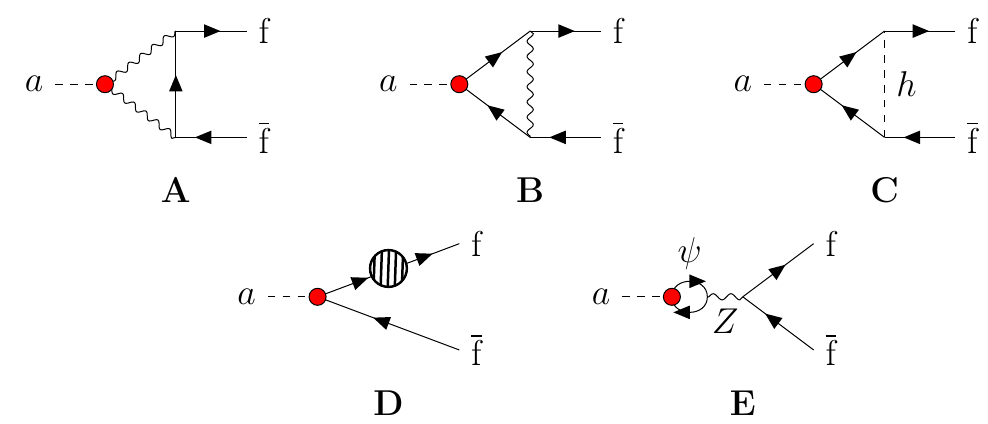
Figure 6 . One-loop diagrams contributing to c f at one-loop (plus the corresponding diagrams with Goldstone bosons). The wavy lines denote gauge bosons: gluons, photons, W and Z